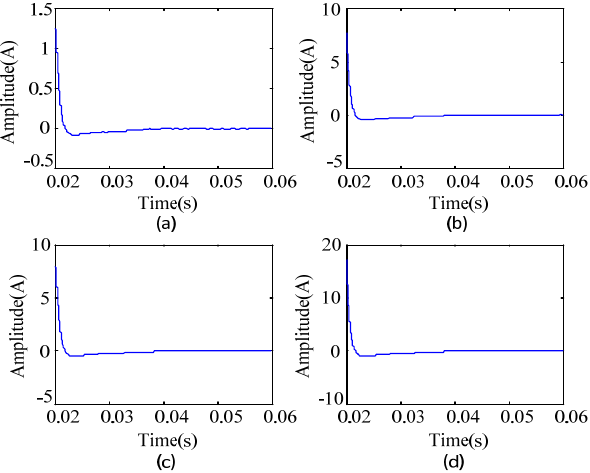
Figure 15. NPFCs after smoothing (Case 3). ( a ) Lian L 1 ; ( b ) Lian L 2 ; ( c ) Lian L 3 ; ( d ) Lian L 4 .